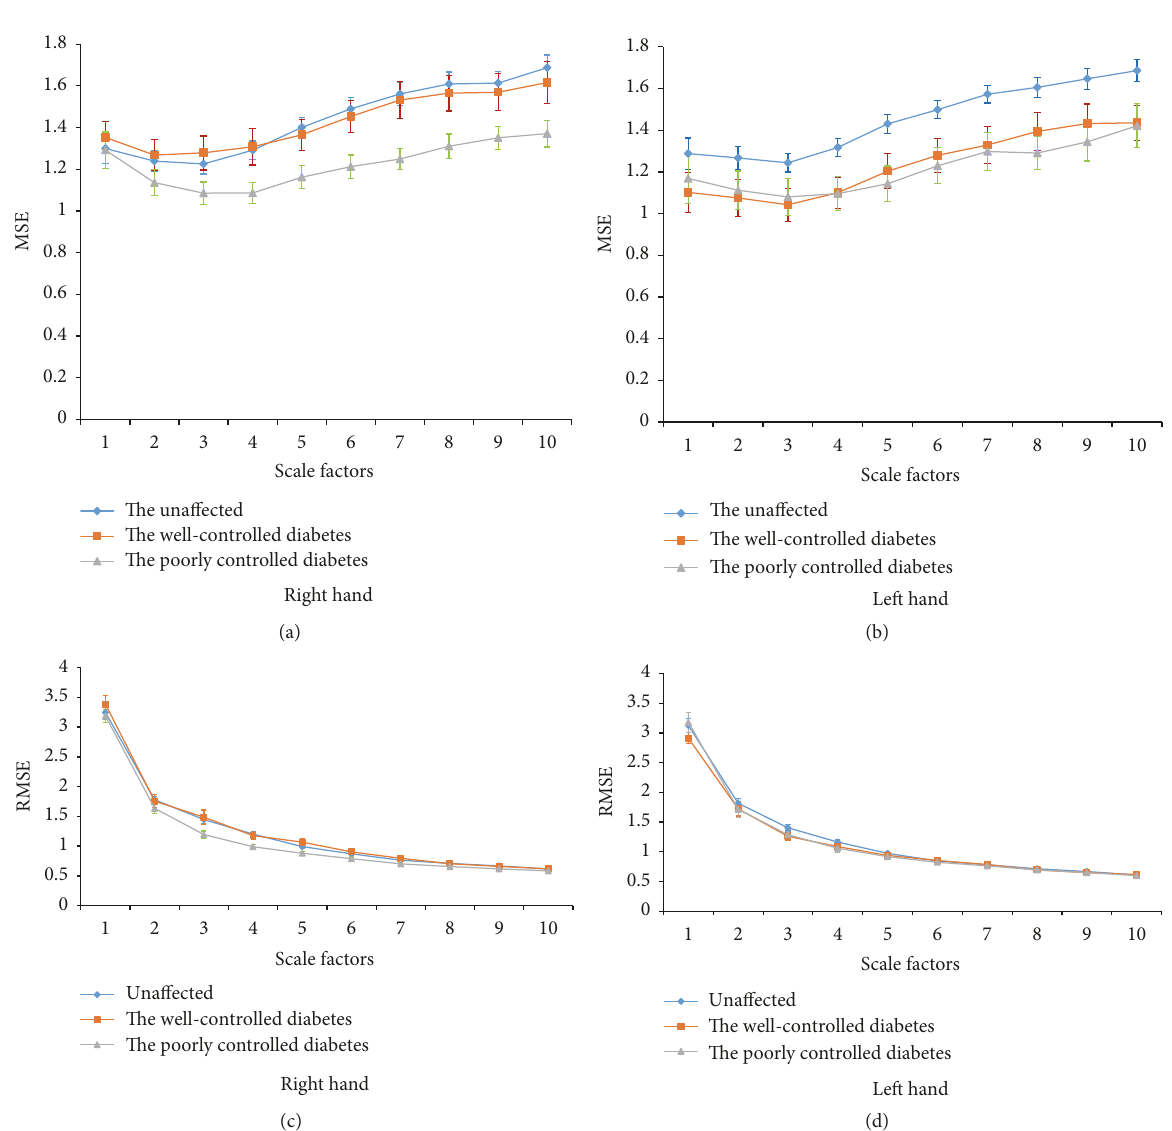
Figure 2: The MSE and RMSE index with the standard error (vertical bar) of the unaffected (solid blue line), the well-controlled diabetes (solid orange line), and the poorly controlled diabetes (solid grey line) groups at each scale factor in left and right hands,